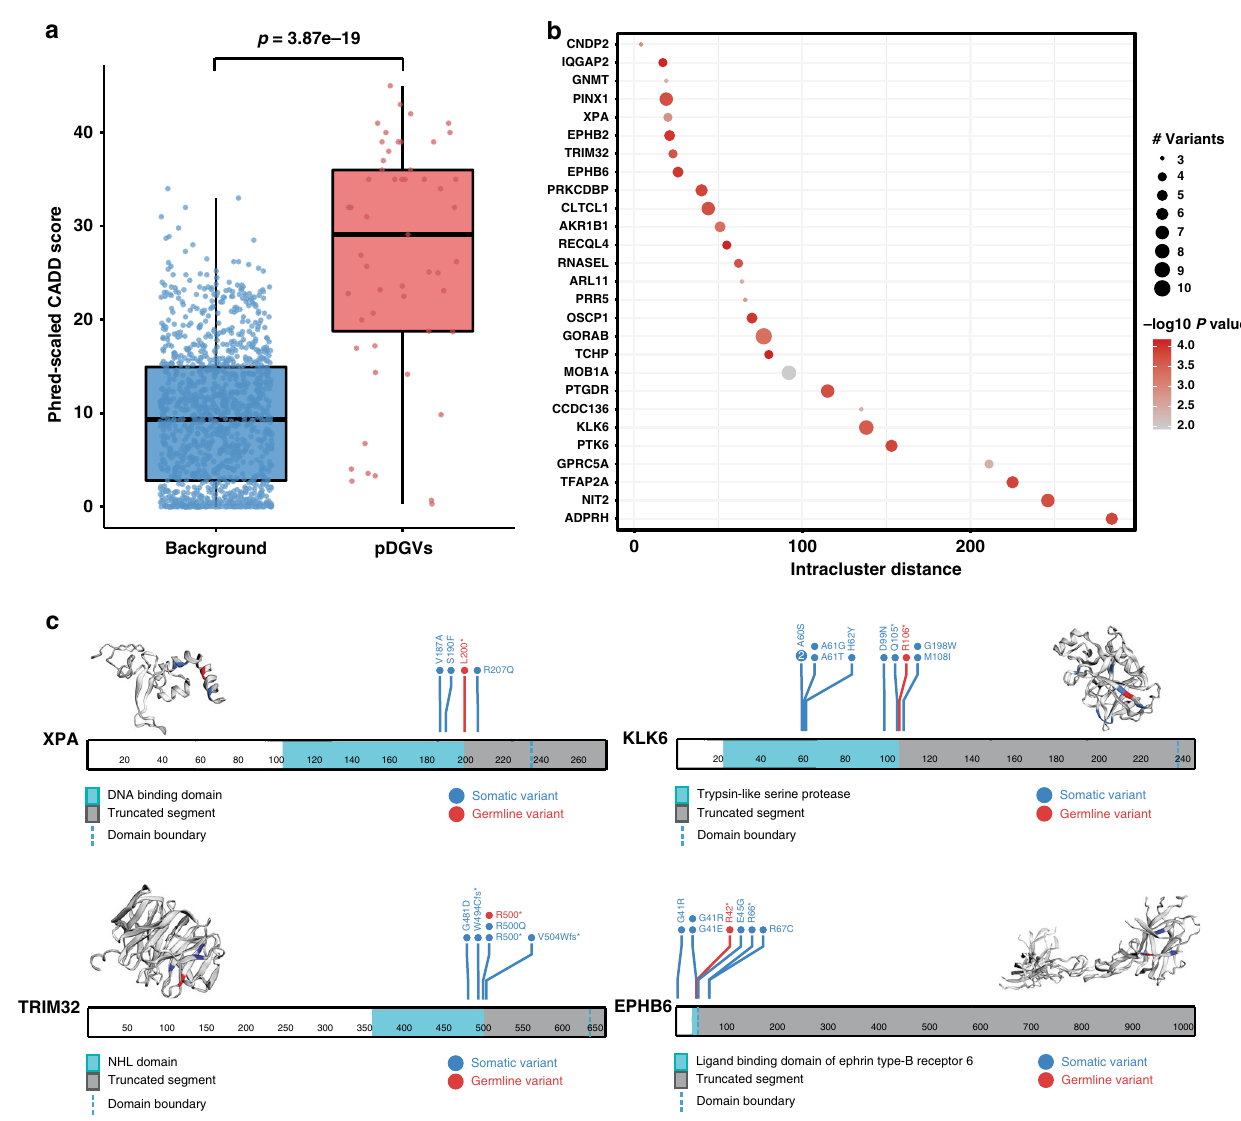
Fig. 3 The impact of pDGVs on protein function. a Phred-scaled CADD scores are higher for pDGVs ( n = 53 variants) than randomly selected control variants ( n = 1249 variants), two-tailed Wilcoxon signed-rank test. The lower and upper edge of the box indicate the 25th and 75th percentiles. The black line in the center of the box indicates the median value; the lower and upper whiskers indicate 1.5 x the interquartile range b Bubble plot represents pDGV- somatic variant clusters for each gene. Circle diameters represent cluster sizes. The intra-cluster distances between amino acid positions are represented on the x-axis. -log10 p -values are represented as shades of red. c Lollipop plots showing the clustering of pDGVs, and somatic variants in XPA, EPHB6, TRIM32 , and KLK6 projected on their 3D protein structures. The truncated segment of each protein is shaded in gray. The boundary of the affected domain is delineated with a dashed line. WCM-UC pDGVs are colored in red, and known somatic variants are colored in blue. Source data are provided as a Source Data fi